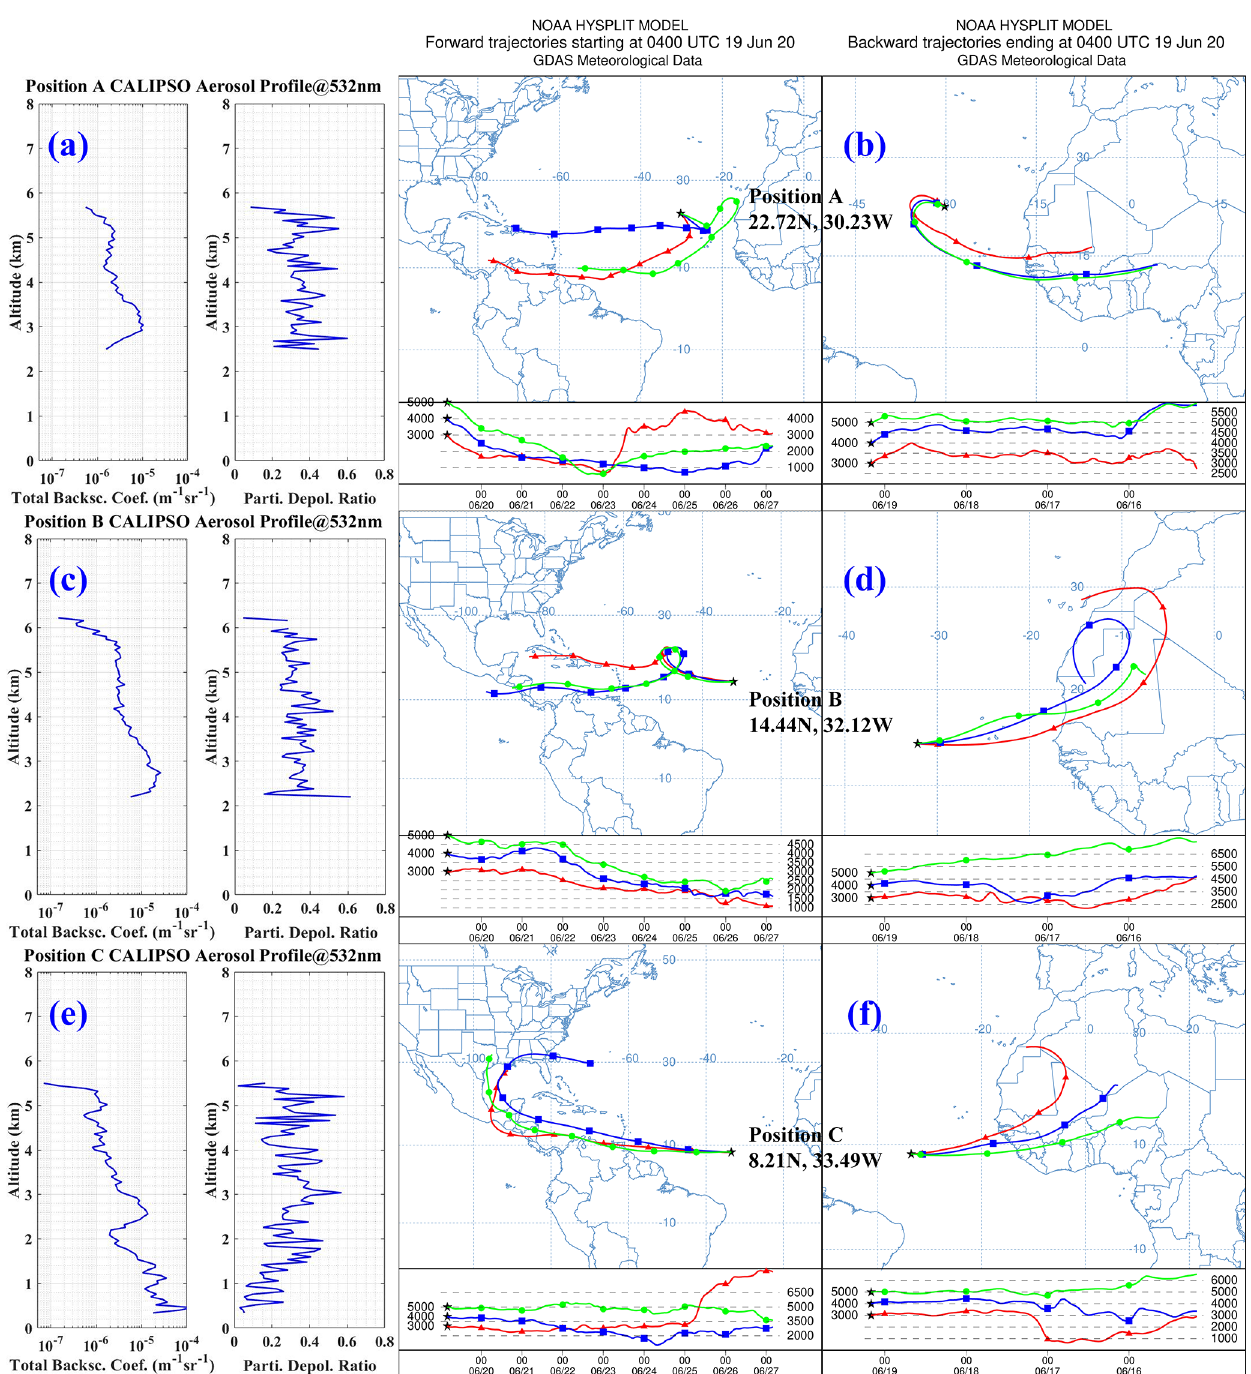
Figure 5. (a, c, e) CALIPSO total backscatter coefficient profiles and particle depolarization ratio profiles capturing dust layers at around 04:00UTC on 19 June 2020. (b, d, f) HYSPLIT backward trajectories and forward trajectories at different positions of corresponding CALIPSO profiles and different altitudes at 04:00UTC on 19 June 2020. The backward and forward trajectories’ durations are 96 and 192h respectively (https://www.ready.noaa.gov/hypub-bin/trajtype.pl?runtype=archive, last access: 23 March 2022).